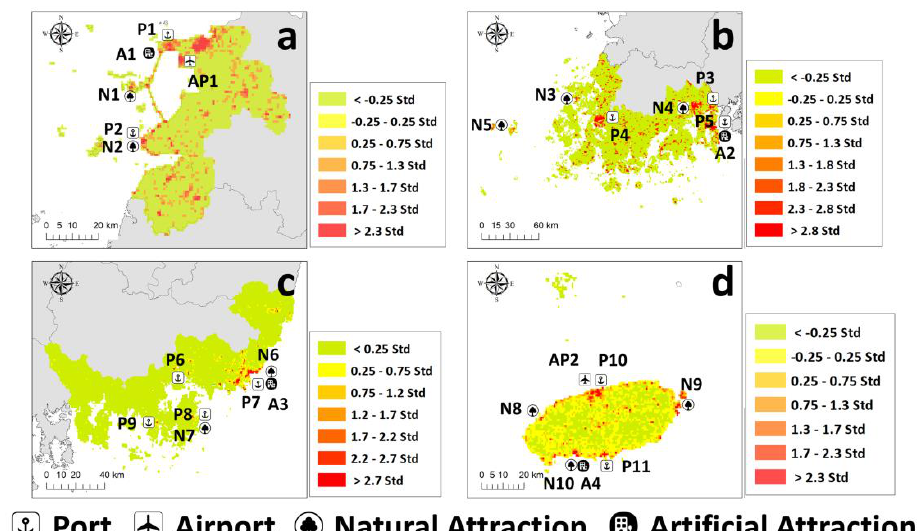
Figure 4. Spatial distribution of coastal tourism visitation rate (people/year ⋅ (30″ ⋅ 30″)); the names of each facility and tourist attraction are referred to in Appendix D: ( a ) Jeollabuk-do (max: 606,851; mean: 12,000; standard deviation: 30,000); ( b ) Jellanam-do (max: 1,698,029; mean: 19,000; standard deviation: 65,000); ( c ) Gyeongsangnam-do (max: 38,484,630; mean: 96,000; standard deviation: 600,000); ( d ) Jeju-do (max: 3,692,085; mean: 60,000; standard deviation: